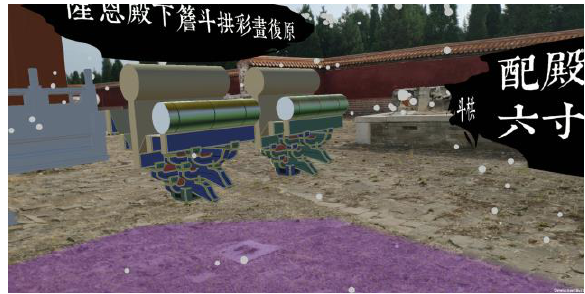
Figure 48. Bucket archs that are separated from the building